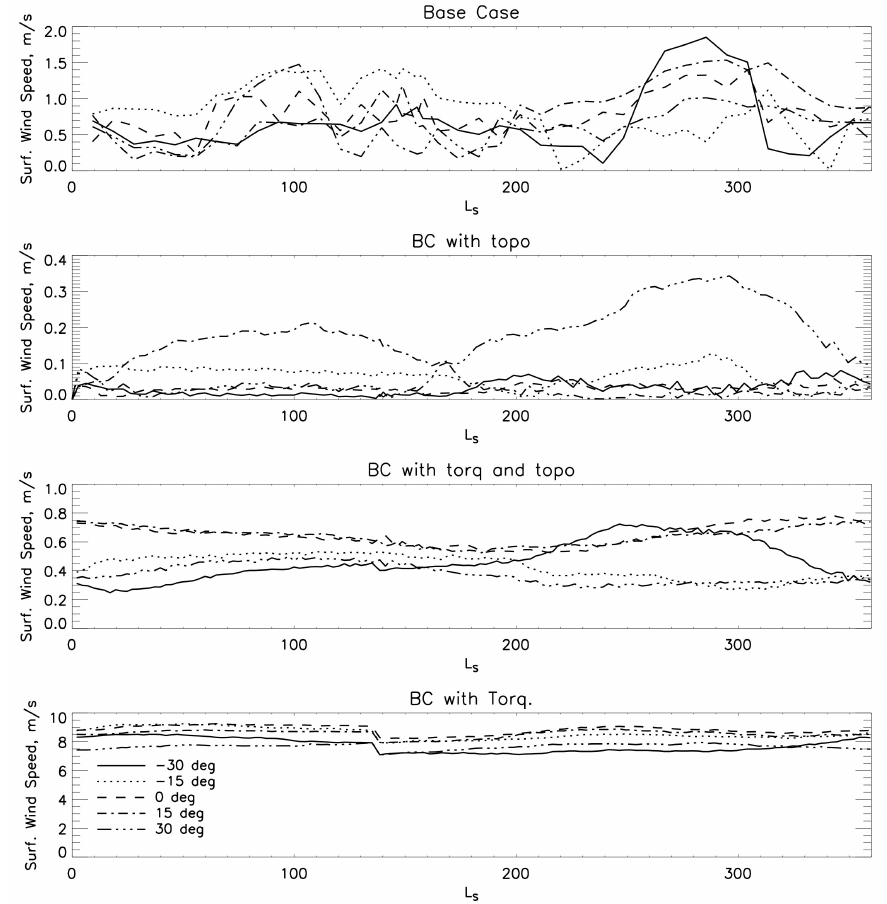
Figure 11. Zonal wind speed over one Titan year in the four simulations. From the top down, they are the base case model (BC), BC with topography, BC with topography and added torque, and BC with added torque. Not the di ff erence in